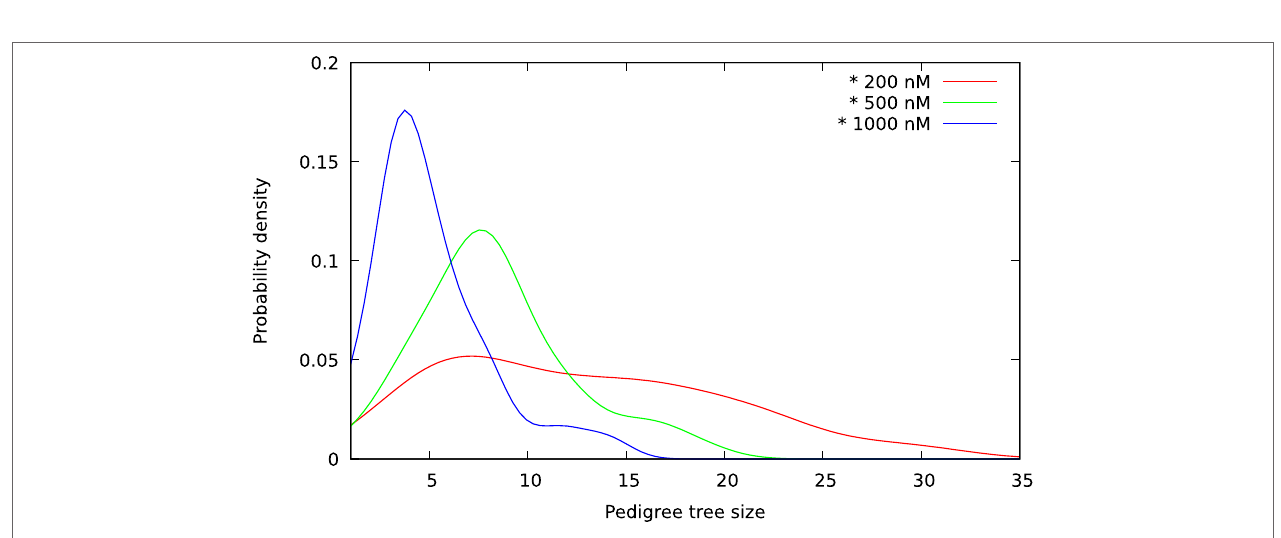
FigUre 9 | Size distributions for pedigree trees from A549 cells exposed to YTX at concentrations 200, 500, and 1,000 nM. These estimates are kernel densities for the size of three sets of 100 pedigree trees (see text). The kernel bandwidths are here according to the rule of thumb of Silverman (36). Note overlap of size for the three distributions.